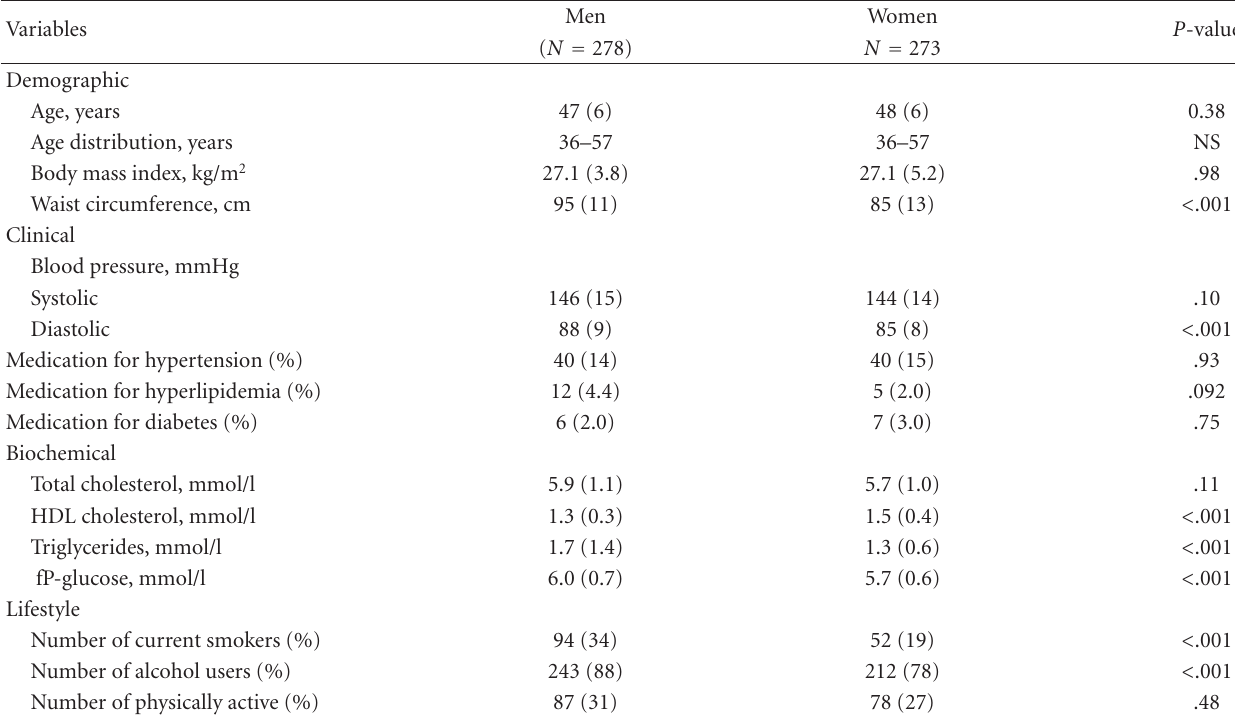
Table 1: Demographic, clinical, biochemical, and lifestyle factors of subjects.